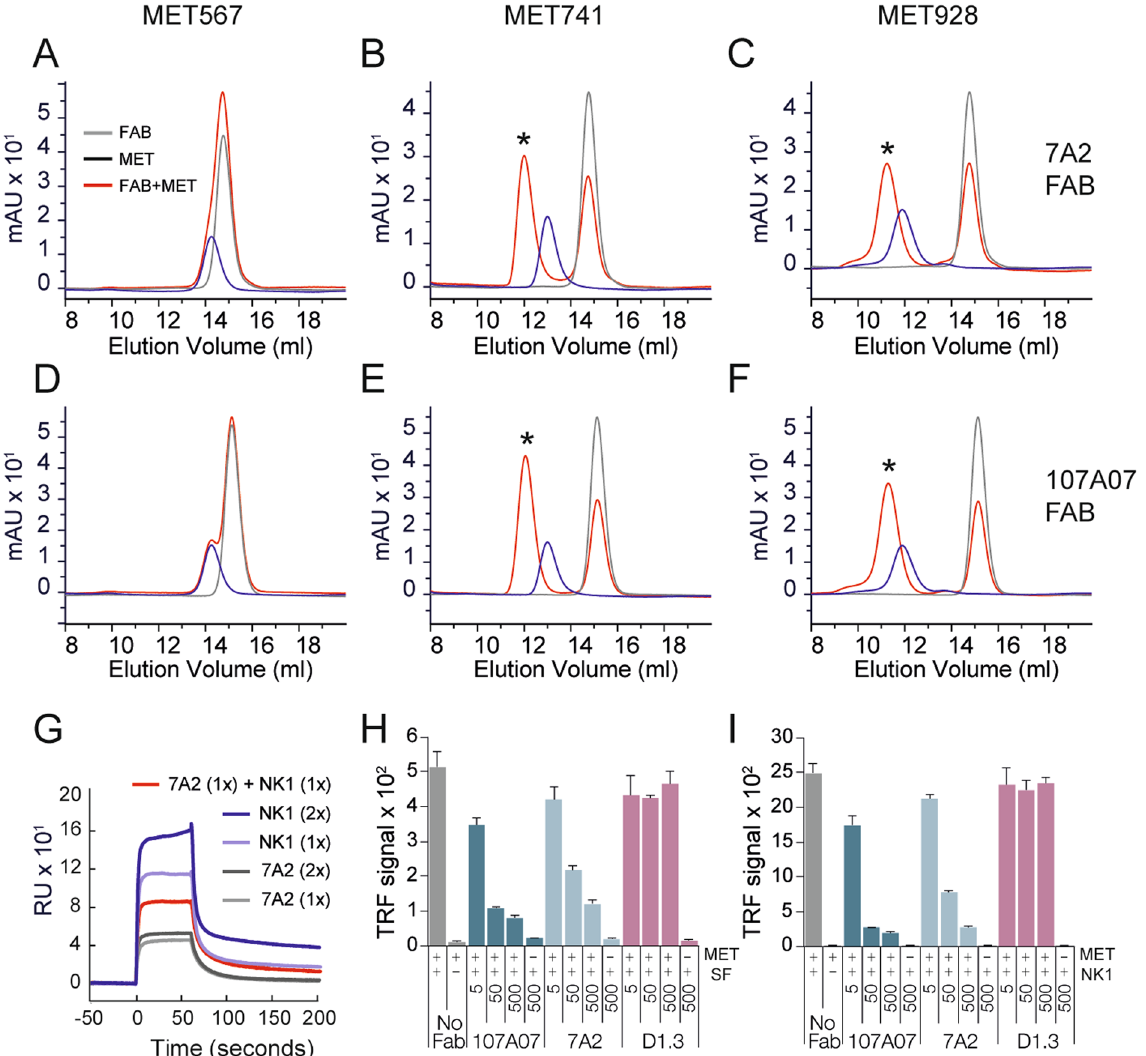
Figure 3. 7A2 and 107_A07 bind within the Ig1-Ig2 domains of MET and compete with NK1 for MET binding. Panels A–F show size exclusion chromatography analysis of 6 µ M Fab 7A2 ( A – C ) or 107_A07 ( D – F ) and 4 µ M MET567 ( A , D ), MET741 ( B , E ) or MET928 ( C , F ), alone or following co-incubation. Y-axis indicates absorbance at 280 nm and x-axis elution volume. Dark blue line, MET alone; gray line, Fab alone; red line, MET/Fab mixture. Peaks present only in MET-Fab mixtures represent complex formation and are marked with an asterix. ( G ) Binding to a MET928-coated CM5 Biacore chip of 7A2 scFv (light gray line, 134 nM), NK1 (light blue line, 238 nM), or 7A2 scFv mixed with NK1 (red line). Binding of higher concentrations of 7A2 scFv (dark gray line, 268 nM) and NK1 (dark blue line, 268 nM) are also shown for comparison. Sensorgrams are shown aligned to the start of each 60 s injection. ( H and I ) Following co-incubation, untagged Fab and His-tagged MET928 were exposed to plates coated with HGF/SF ( H ) or NK1 ( I ) and bound MET928 detected with anti-5xHis peroxidase (Qiagen). Data represent mean and standard deviation of a minimum of three replicates per sample. Fab were tested at 5, 50 and 500